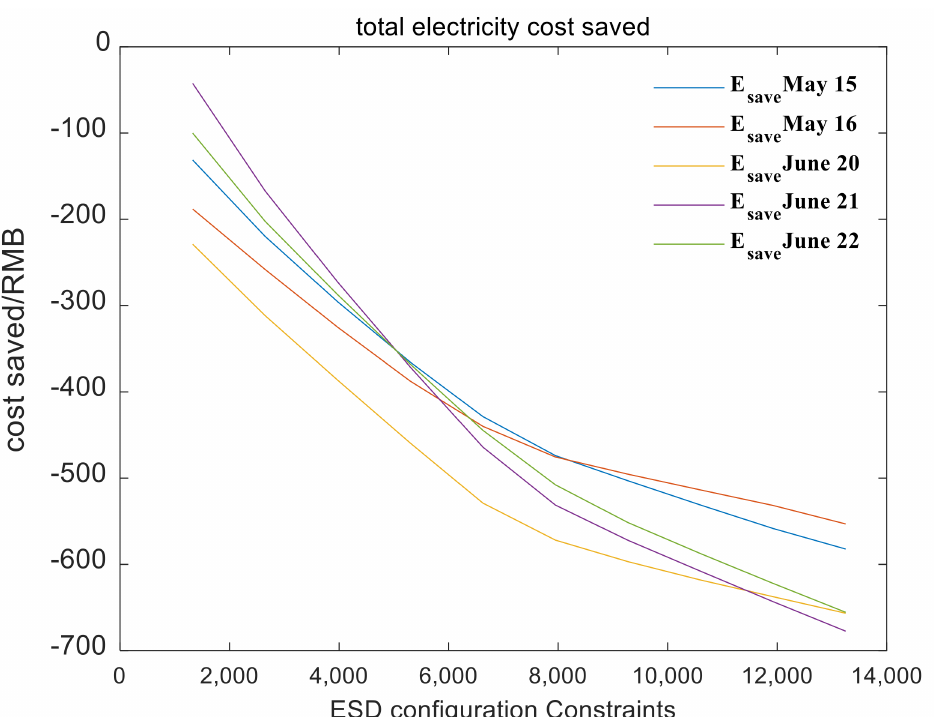
Figure 13. Decreased amplitude of total electricity cost with comprehensive